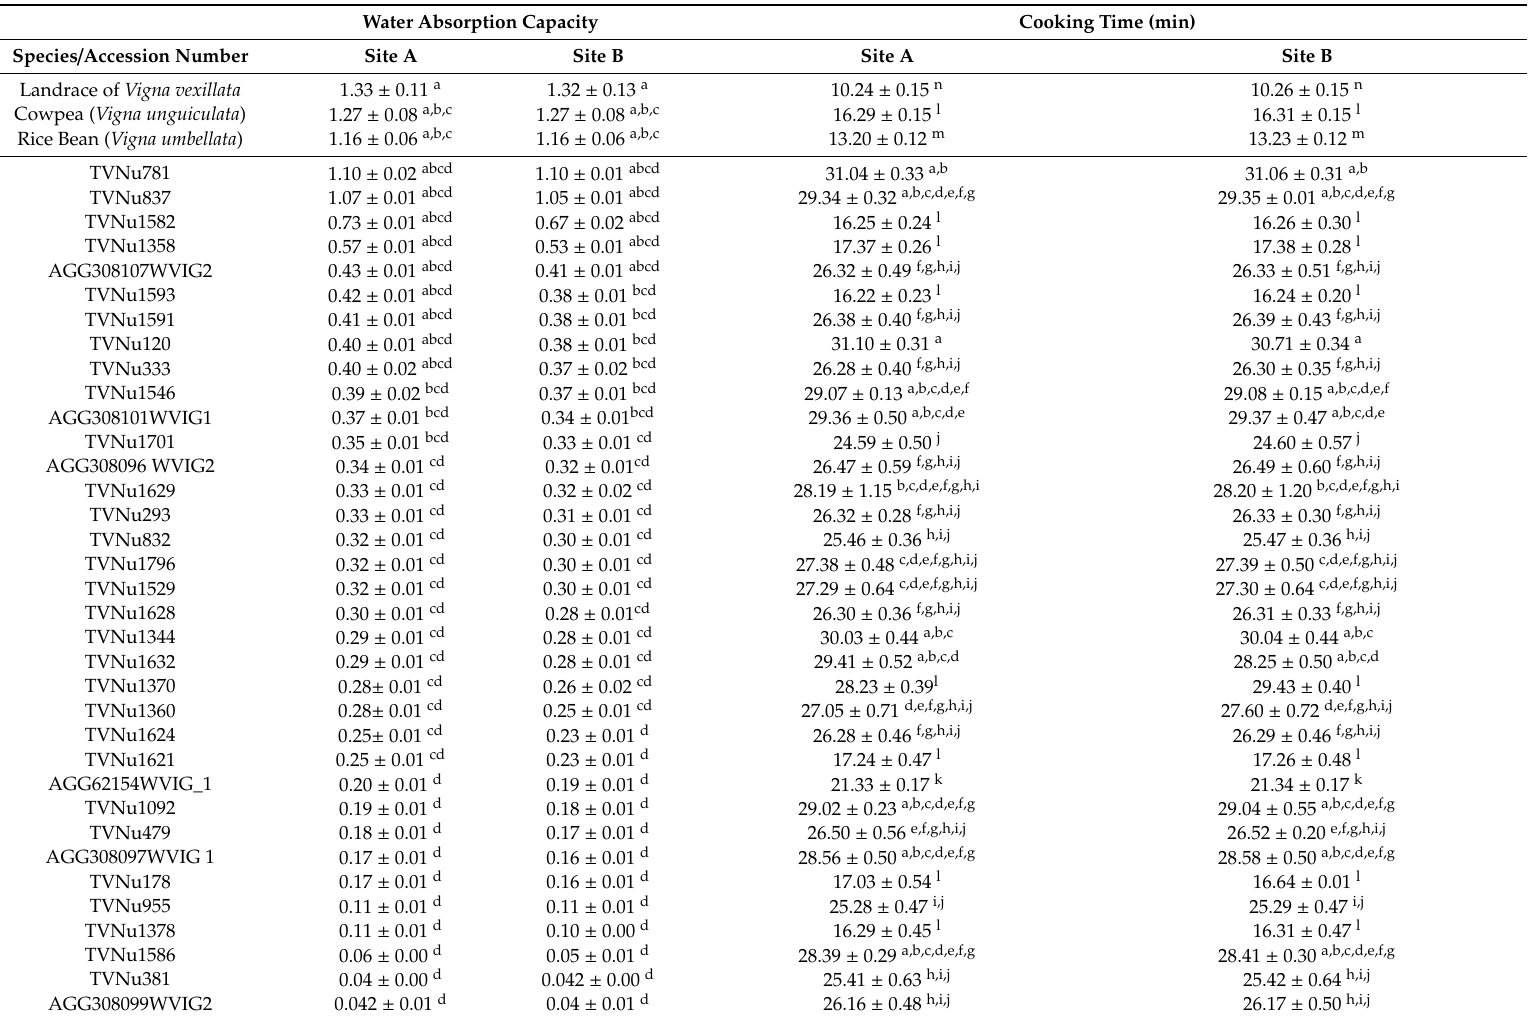
Table 4. Cooking time and water absorption capacity of Vigna vexillata